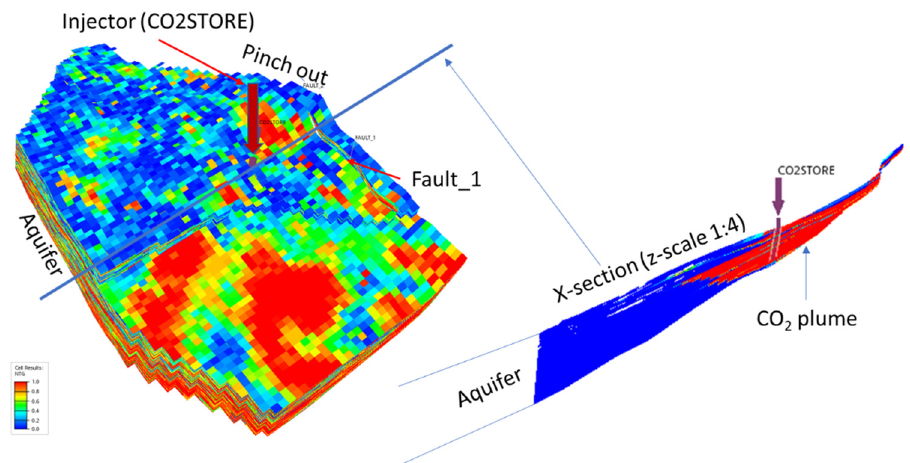
Figure 12. Simulation of CO 2 injection at LBr-1 geological setting (Eclipse reservoir simulator): perspective view with effective pore volume distribution and cross-section showing the mid-reservoir well position with color indicating CO 2 saturation after end of injection.